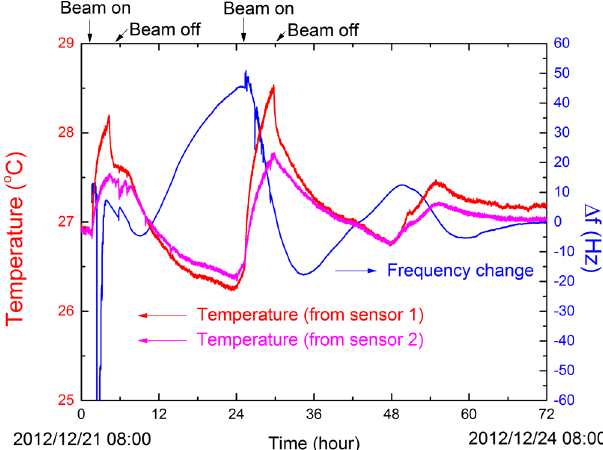
FIG. 12. Effects of the ambient temperature on the frequency change. The frequency change of the vibrating wire and the temperature of the HINS facility were monitored over three full days. On the first two days, the beam was turned on, while on the thirdday,therewasnoexperiment.ThepositionscanningoftheLA- WVM was done only for the first day. On the second day, the LA- WVM was parked in the outermost position from the beam